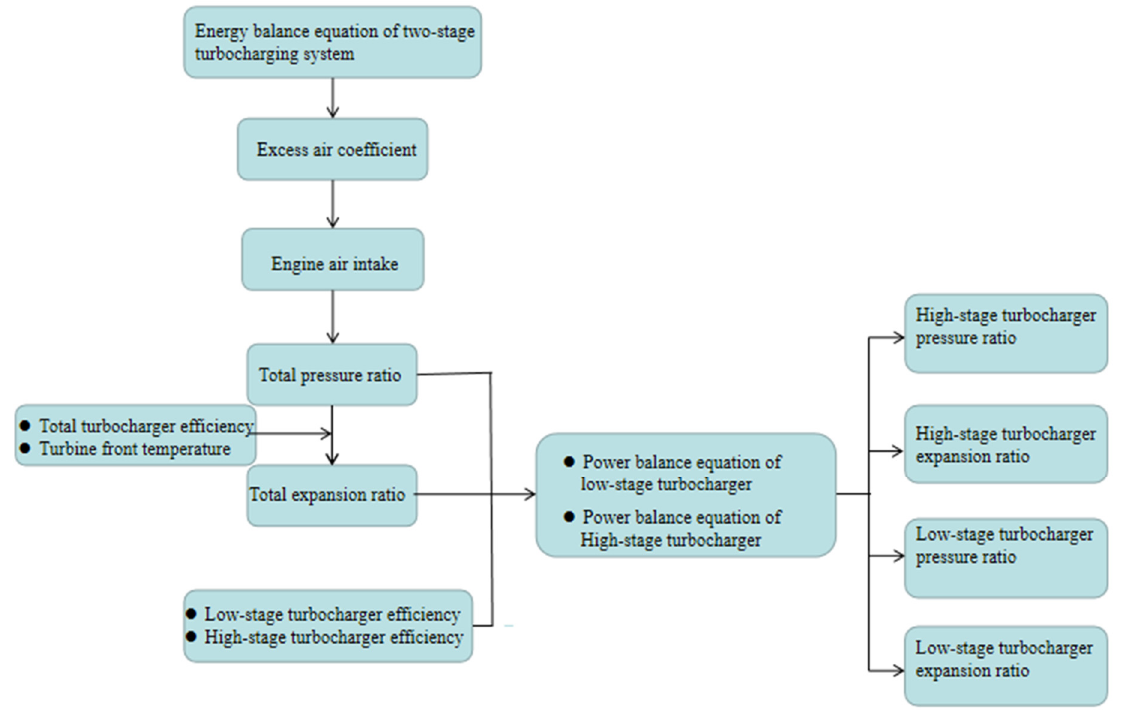
Figure 1. Calculation model logic diagram.